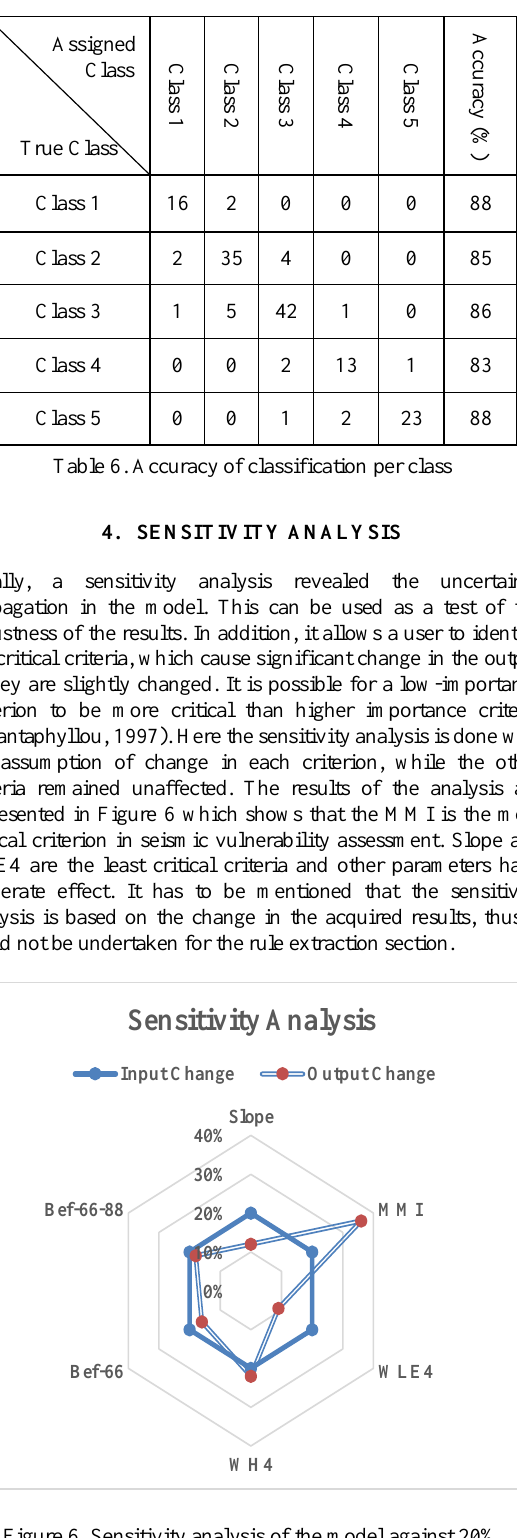
Figure 6. Sensitivity analysis of the model against